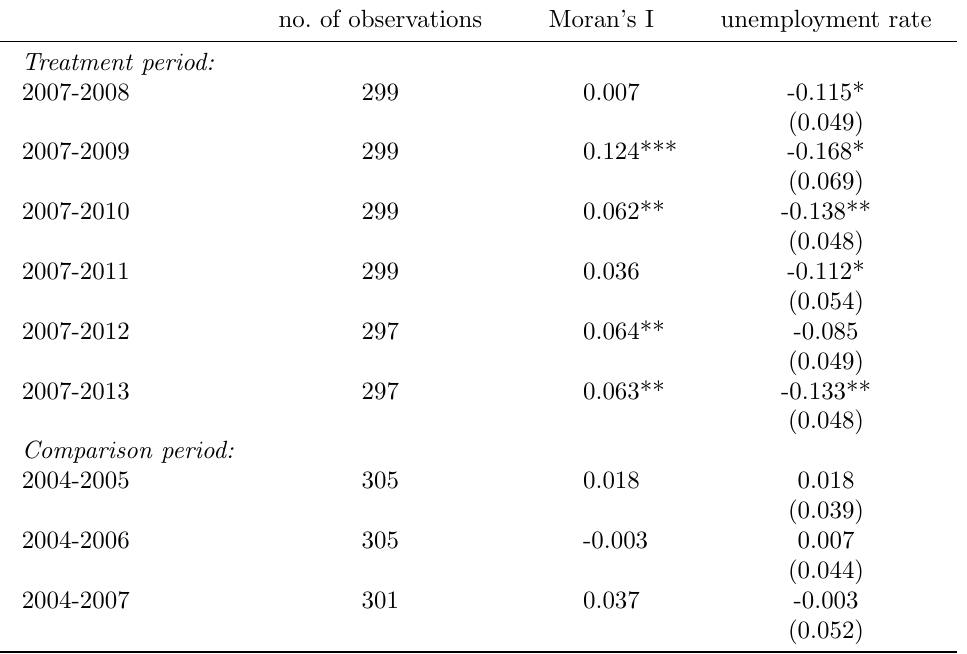
Table 6: Moran’s spatial correlation measures and spatial regression coefficients, previous transitional